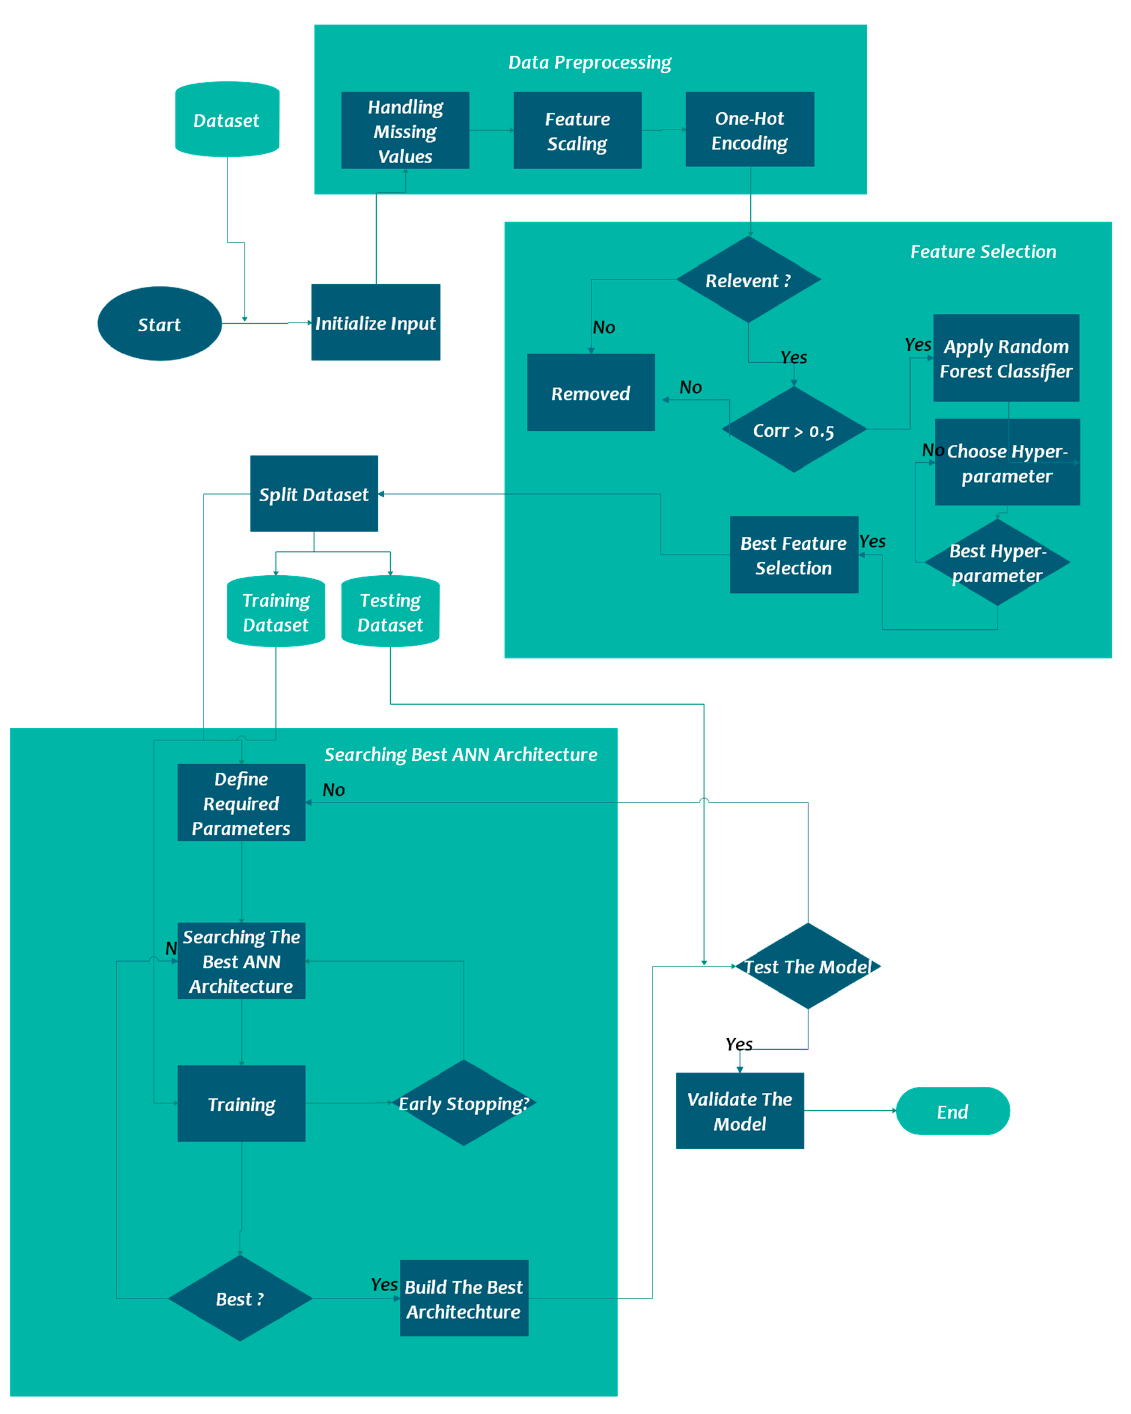
Figure 5. ANN-based detection system fl ow.